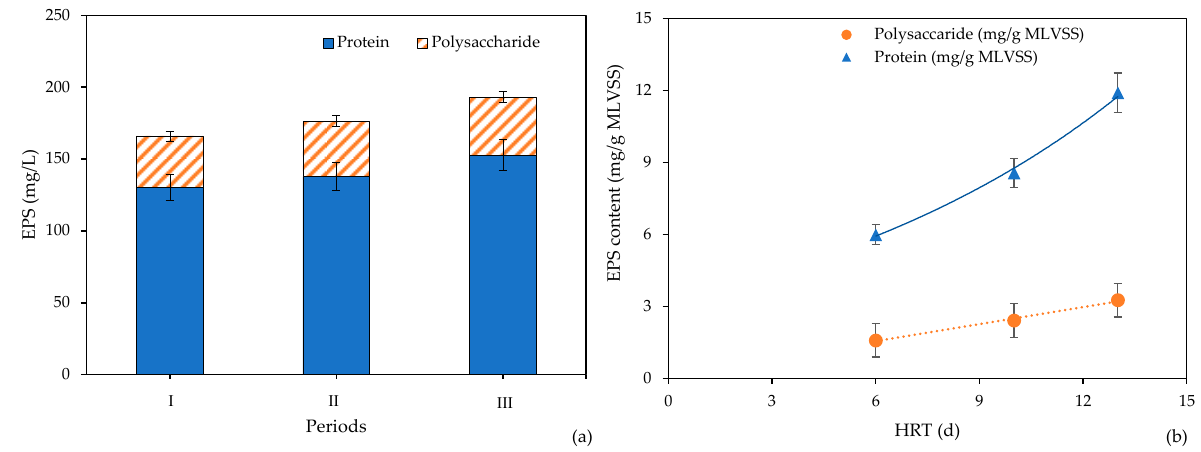
Figure 2. EPS characteristic: ( a ) composition and ( b ) specific EPS content as a function of HRT.